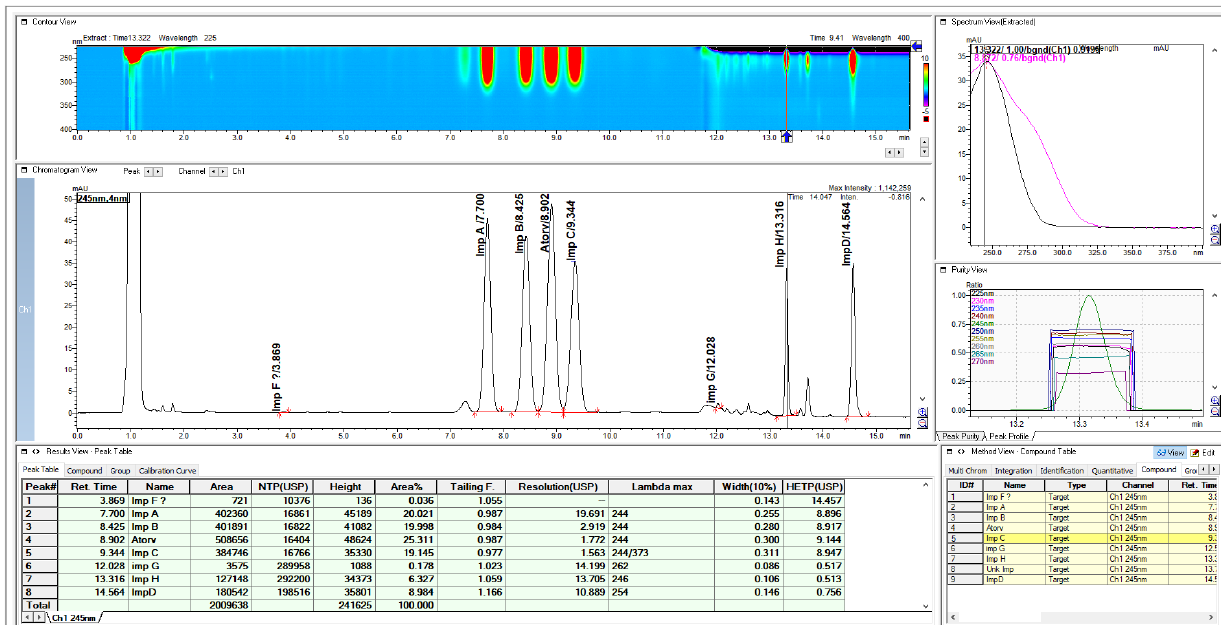
Figure 6. Separation of atorvastatin and its impurities using Poroshell C18ec 100 mm × 4.6 mm, 2.7 µ m, with 3 µ L injection volume.